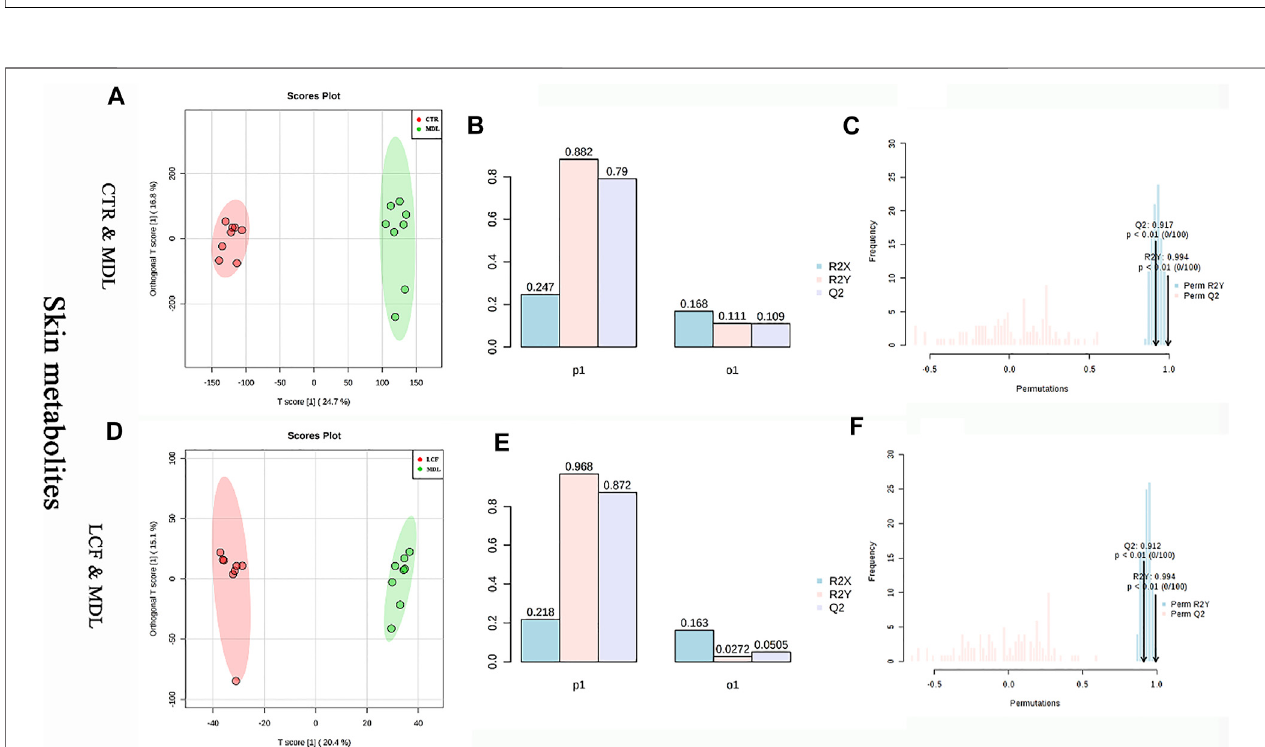
FIGURE 6 | OPLS-DA statistical model between skin metabolites. (A) CTR and MDL OPLS-DA plot, (D) LCF and MDL OPLS-DA score map, (B/E) OPLS-DA parameter test, (C/F) : OPLS-DA alignment test.